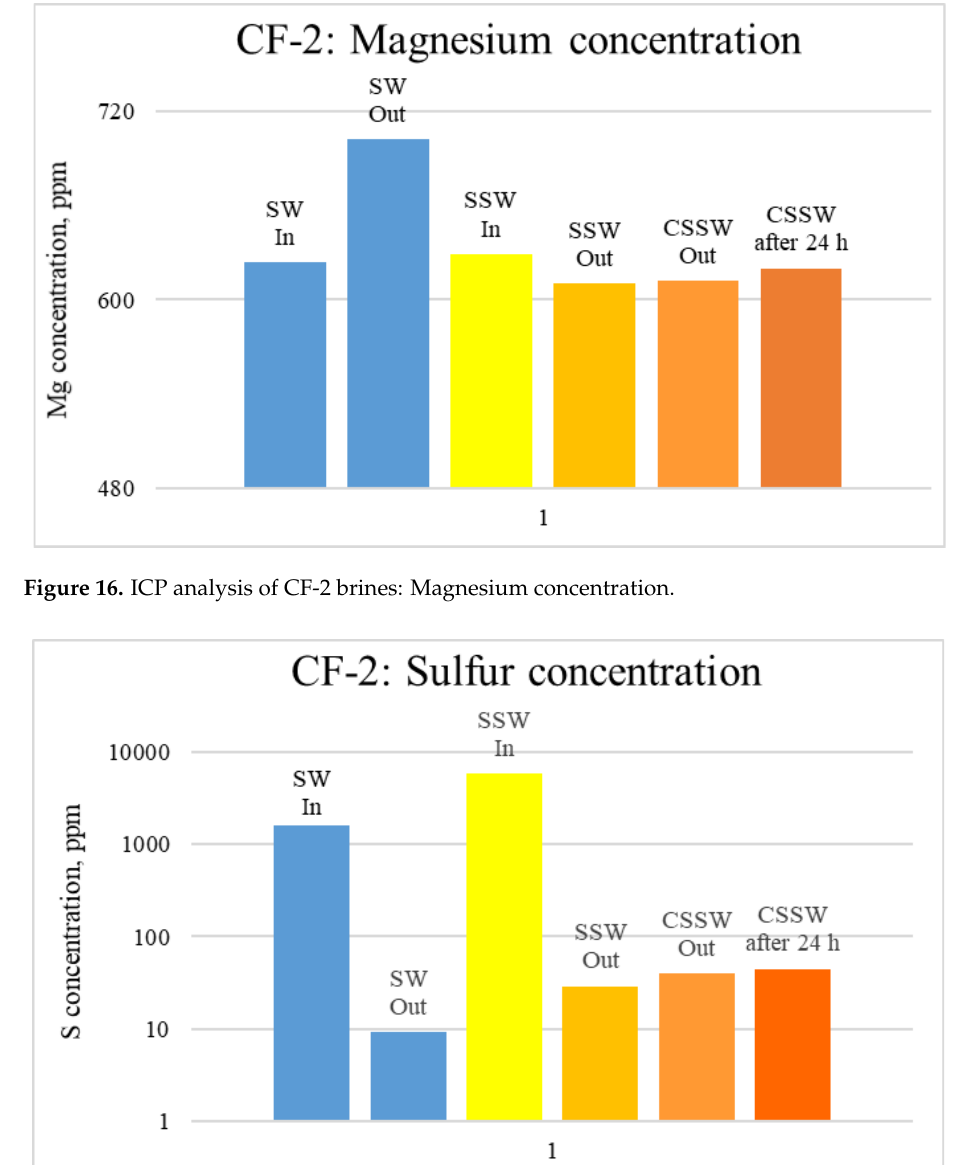
Figure 15. ICP analysis of CF-2 brines: Calcium concentration.